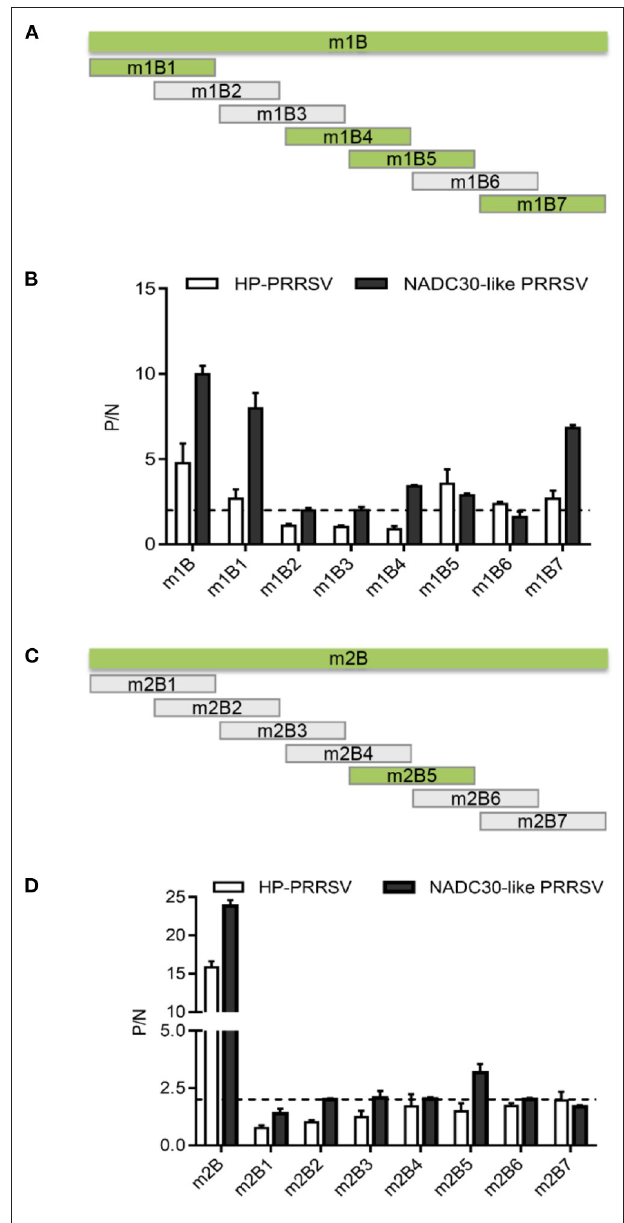
FIGURE 4 | Immunoreactivity of m1B and m2B truncated peptides. (A) Schematic diagram of overlapping m1B1–m1B7 short peptides used for epitope mapping. The green box represents peptides that reacted strongly with PRRSV-positive serum, whereas the gray box represents peptides that reacted only weakly. (B) P/N ratio for m1B1–m1B7 in indirect ELISA. (C) Schematic diagram of overlapping m2B1–m2B7 short peptides. (D) P/N ratio for m2B1–m2B7 in indirect